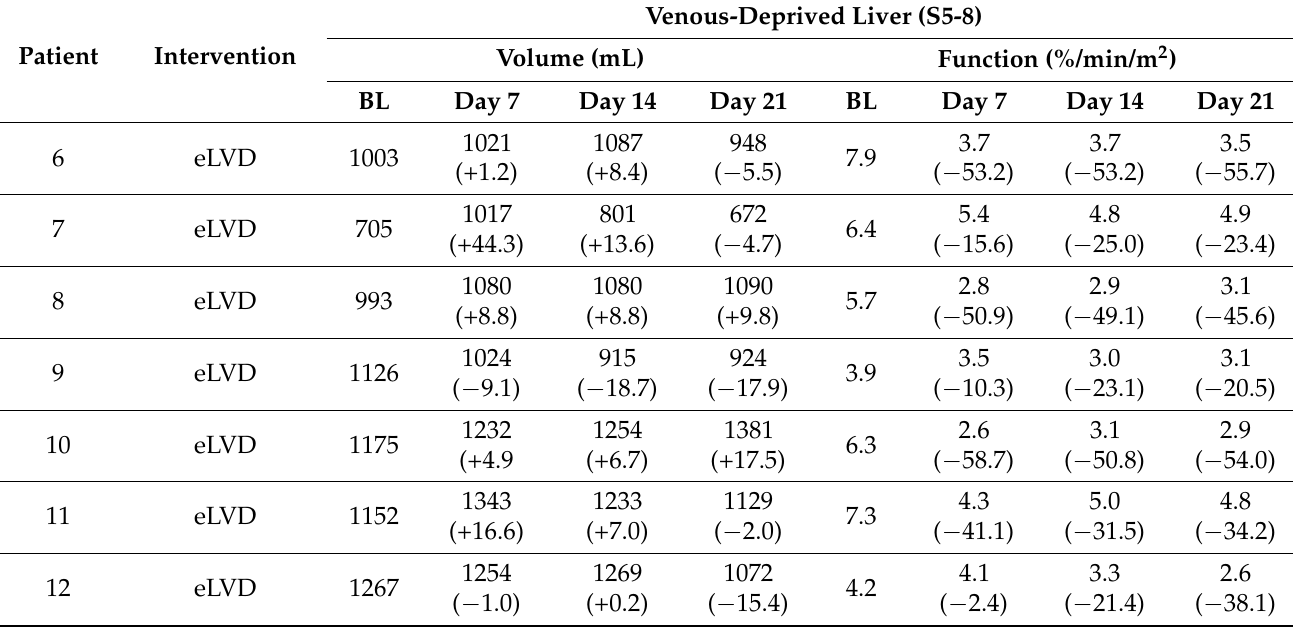
Table 3. Volume and function raw data in the venous-deprived liver (S5-8 after